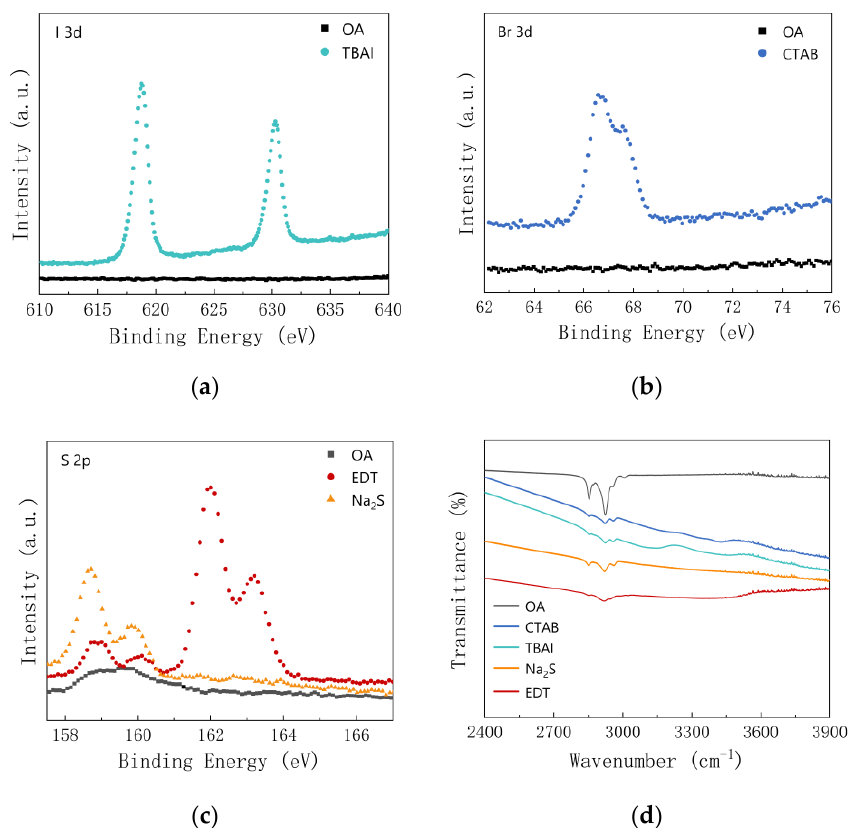
Figure 5. ( a – c ) XPS analysis of OA-treated (black), TBAI-treated (green), CTAB-treated (blue), EDT- treated (red), and Na 2 S-treated (orange) PbS QD films. ( d ) FTIR spectra of PbS QD films with different ligands. The spectra are offset for clarity.